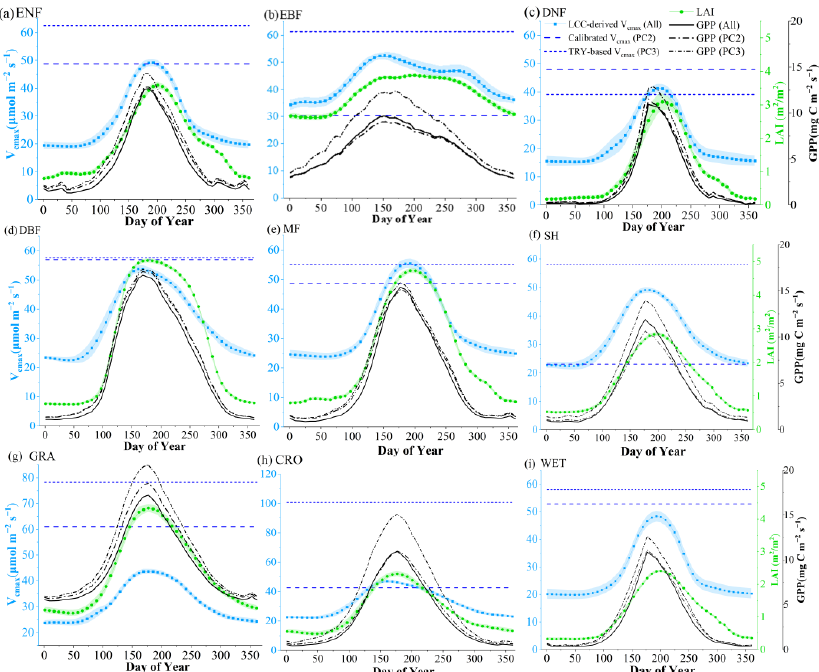
Figure 7. Seasonal dynamics of V cmax (blue), LAI (green), and GPP (black) for nine PFTs: ( a ) evergreen needleleaf forest (ENF), ( b ) evergreen broadleaf forest (EBF), ( c ) deciduous needleleaf forest (DNF), ( d ) deciduous broadleaf forest (DBF), ( e ) mixed forest (MF), ( f ) shrublands (SH), ( g ) grasslands (GRA), ( h ) croplands (CRO), and ( i ) wetland (WET). Consequently, these differences in V cmax (Figure 8a, c) led to synchronous changes in the GPP estimated by the FGM (Figure 8b, d). In comparison with the GPP from “PC2” (Figure 8b), in spring and autumn, the inclusion of the LCC-derived V cmax reduced the overestimation of GPP for all the PFTs, especially for MF, DBF, DNF, and ENF. In summer, the LCC-derived V cmax reduced the overestimation of GPP for GRA and the underestima- tion of GPP for CRO, SH, MF, and EBF. In comparison with the GPP from “PC3”, the inclusion of the LCC-derived V cmax reduced the overestimation of GPP using the TRY- based V cmax (Figure 8d).